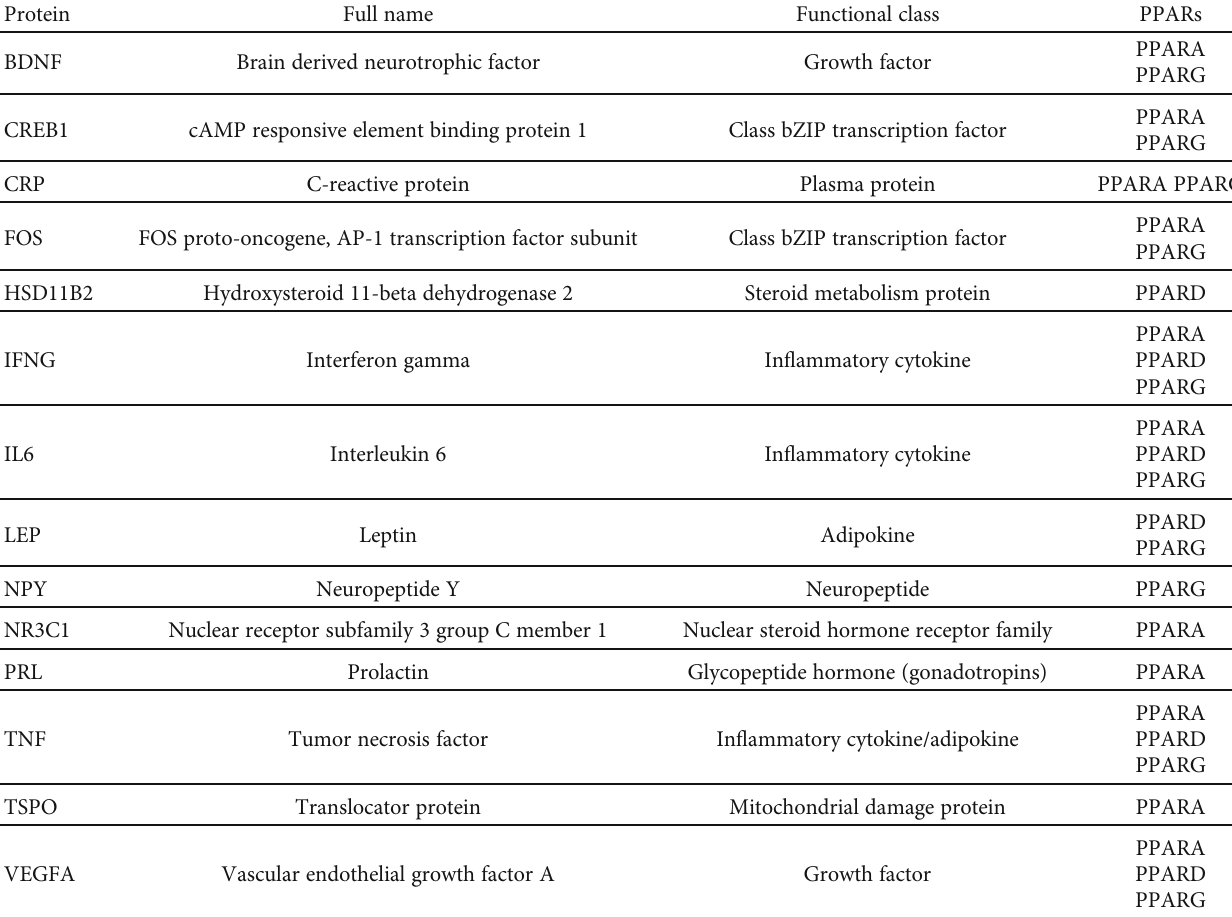
Table 1: List of 14 anxiety-associated proteins – targets of